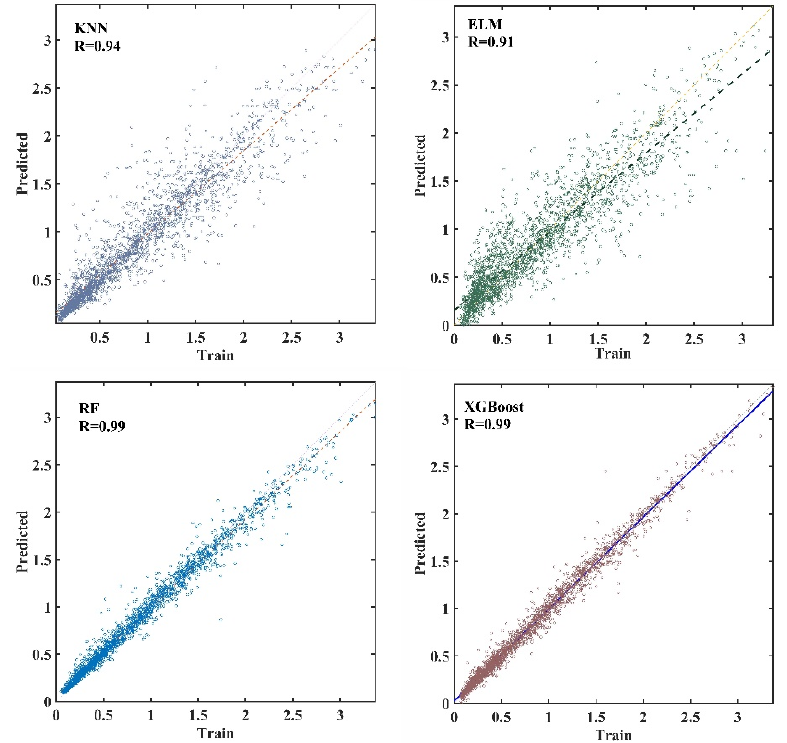
Figure 2. Characteristics of training results of four models.